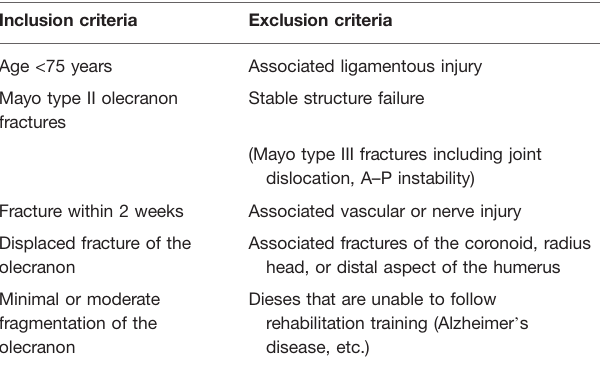
TABLE 1 | Inclusion and exclusion